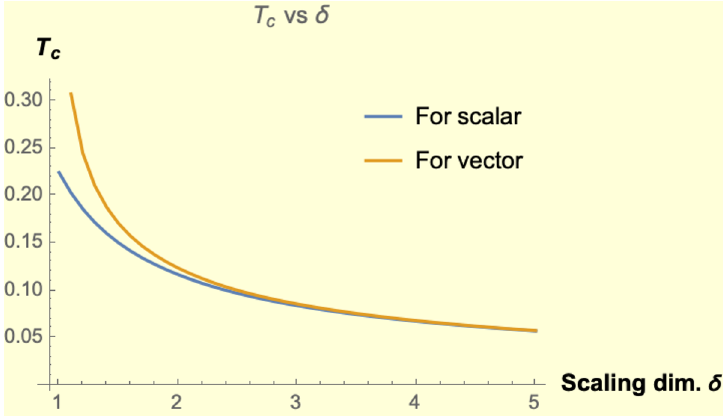
Figure 4. Comparing T c in the Vector vs Scalar